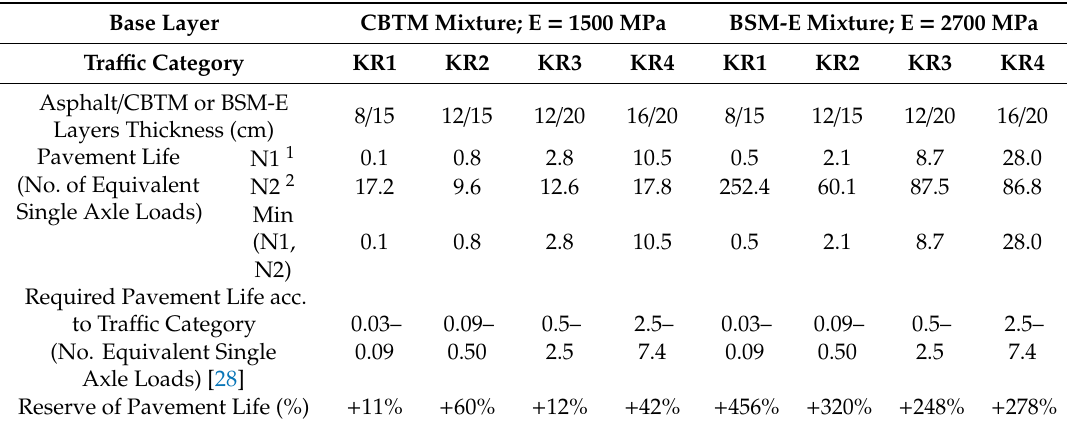
Table 4. Calculated pavement life of flexible pavement structures with CBTM and BSM-E base layers.